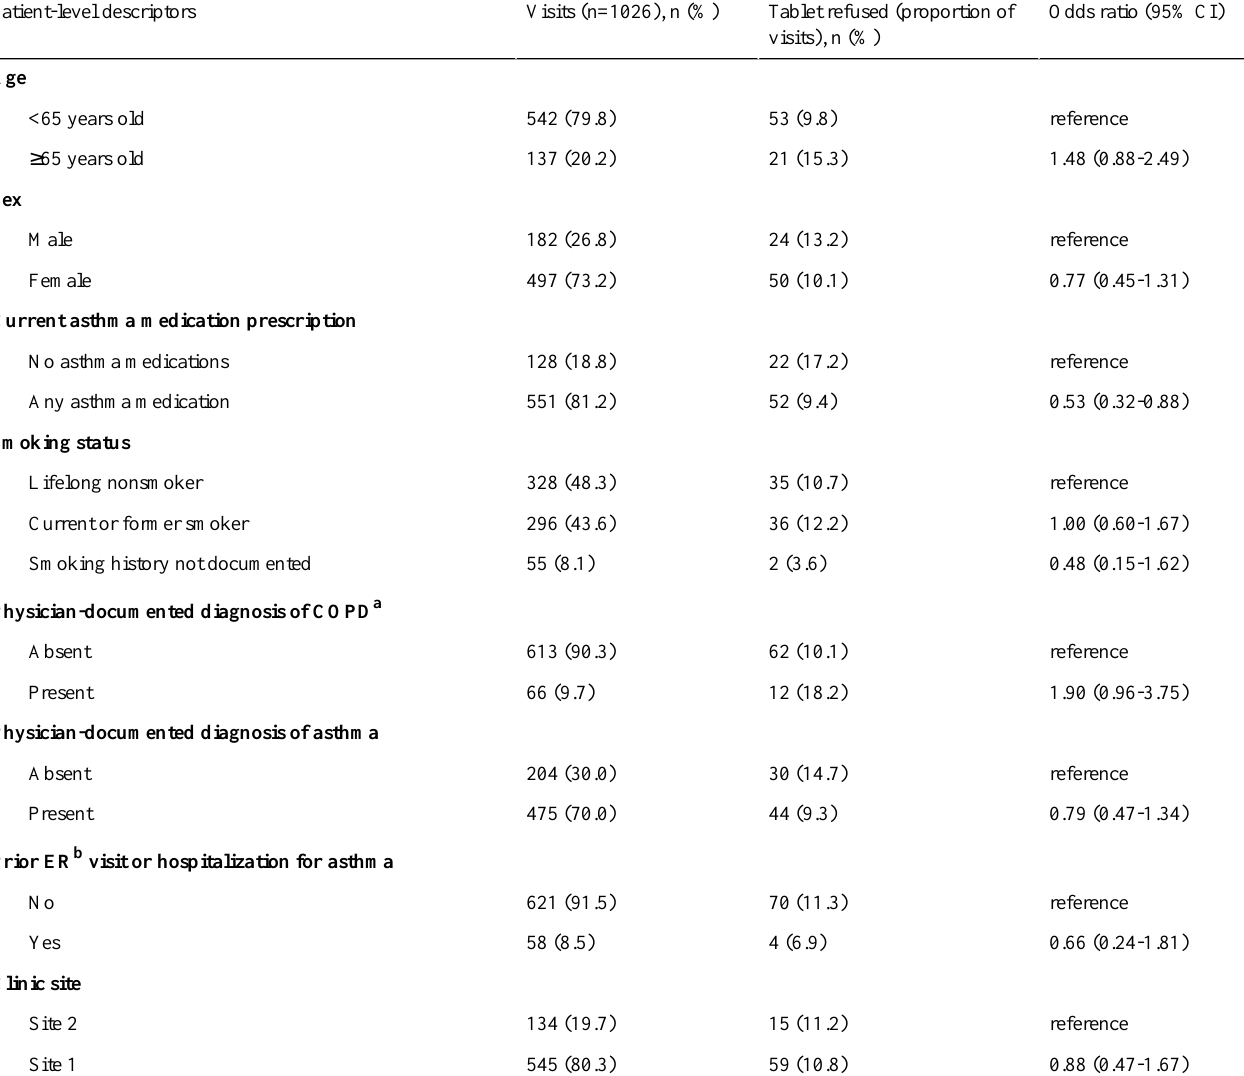
Table 4. Predictors of failure to complete the questionnaire after tablet acceptance.